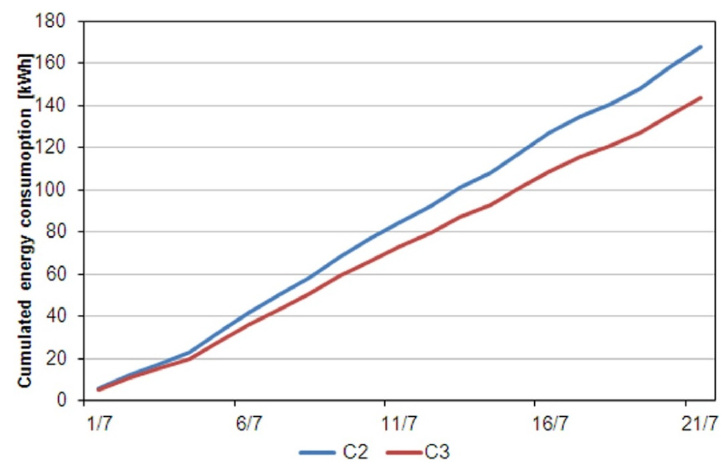
Figure 10. Cumulated consumption of cooling configuration (c) of Table 2.